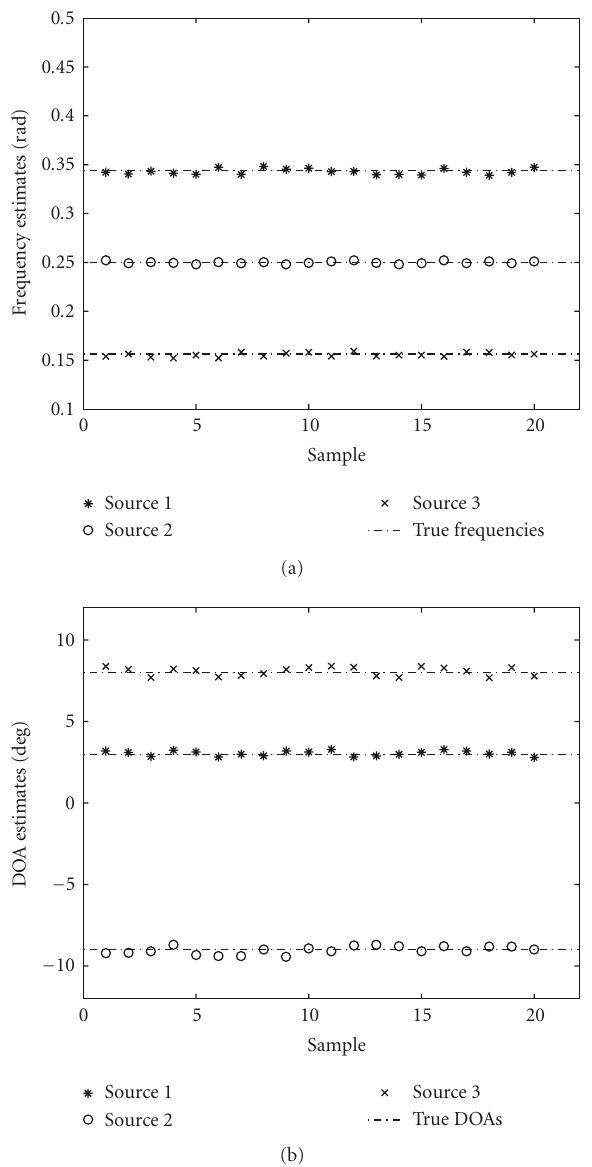
Figure 13: Frequency and DOA estimates with the proposed methods by using experimental data. ( M = 8, K = 4, N = 256). (a) Frequency estimation. (b) DOA